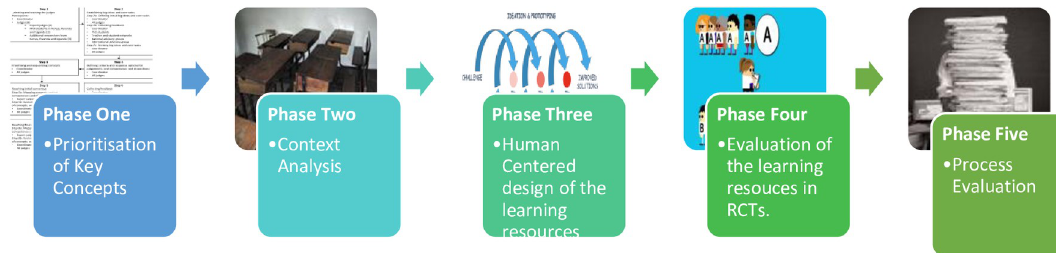
Fig 1. Overview of the research project.